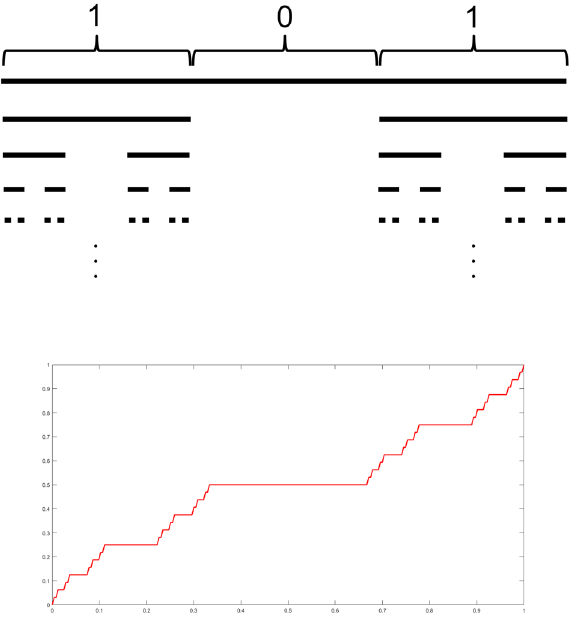
Figure 1: C 1,0,1 ( ) and F 1,0,1 ( )